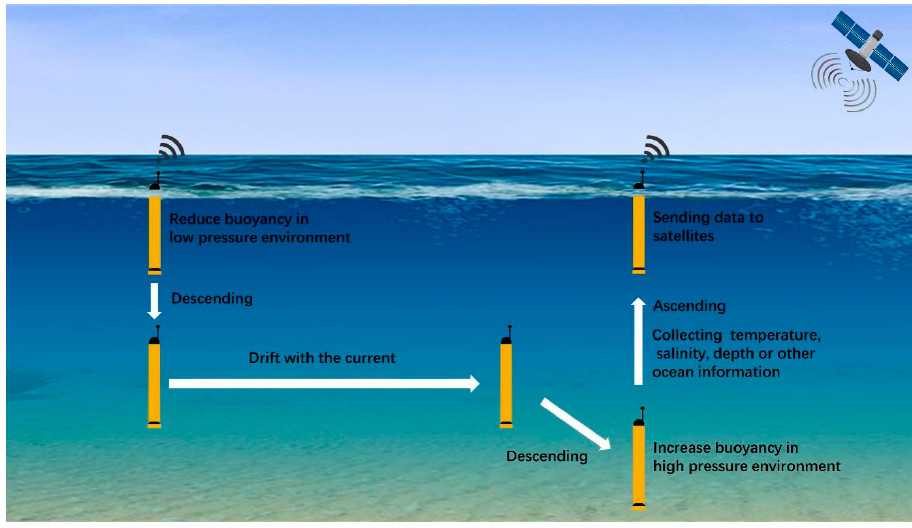
Figure 1. Schematic diagram of the working process of an underwater profiler.